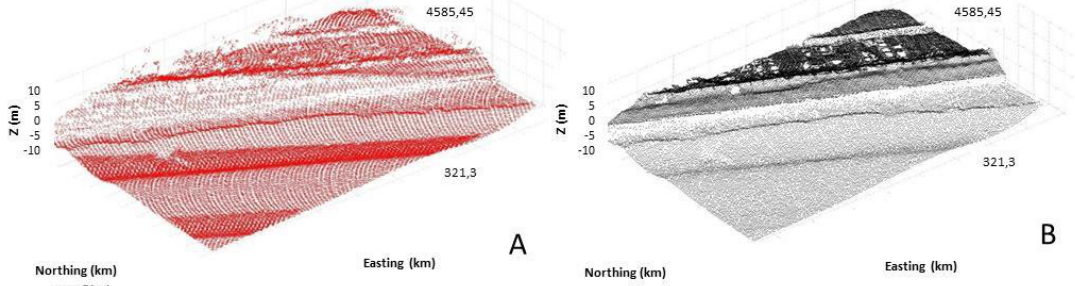
Figure 5. Three-dimensional representation of the different density and spatial distribution obtained for ( a ) point cloud and ( b ) final DSM. The comparison shows the greater dispersion of the LiDAR point cloud (presence of abnormal measurements or peak) compared to the final 4X4 DSM.